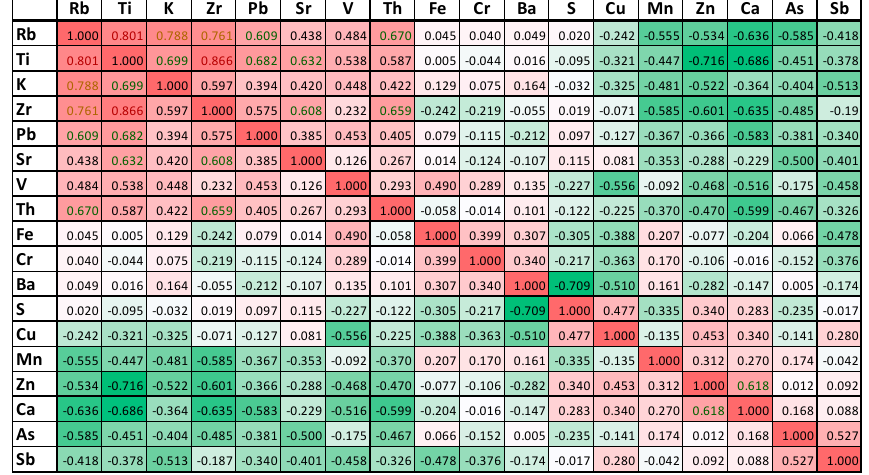
Table 3. Elementary statistics for Ah horizon observations, pXRF measurements (in mg/kg).